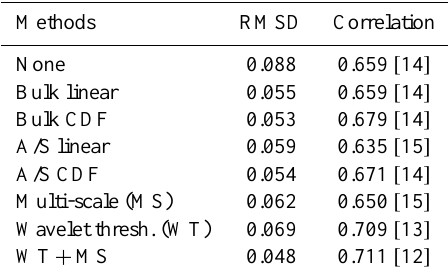
Table 1. RMSD (in units of m 3 m − 3 ) and correlation between INS and AMS SM at Kyeamba treated by various methods. The square brackets contain the 95% confidence